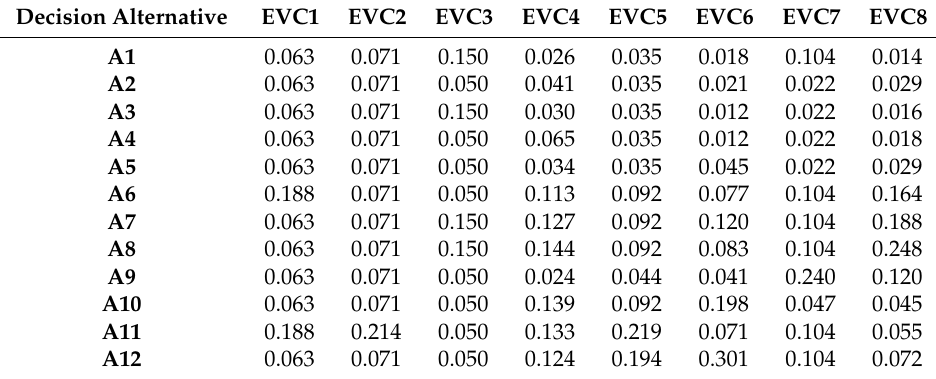
Table 4. Relative weights of decision alternatives A1–A12 with respect to